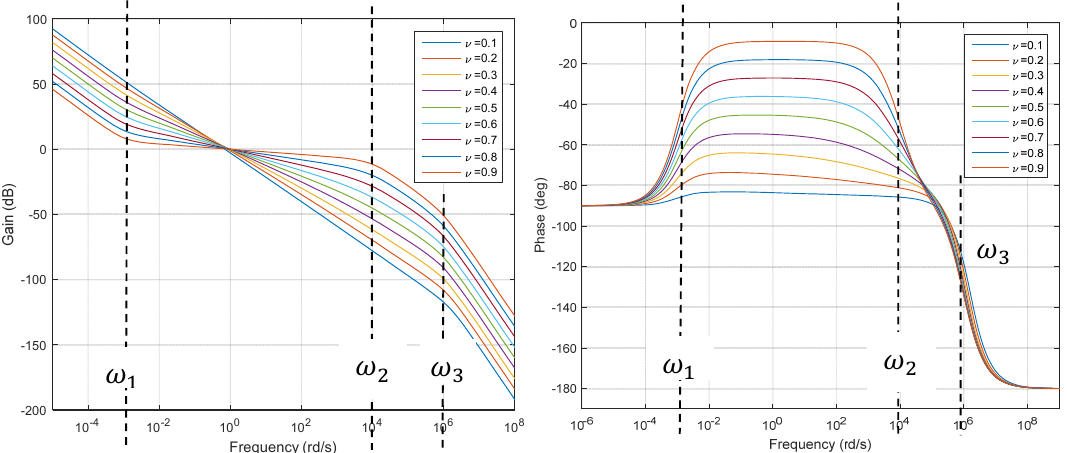
Figure 9. Gain ( left ) and phase ( right ) diagrams of x ( s ) / u ( s ) for various values of ν where corner frequencies ω 1 = 10 − 3 rd / s , ω 2 = 10 4 rd / s , and ω 3 = 10 6 rd/s depend on parameters A 0 , A 1 , and B [34].